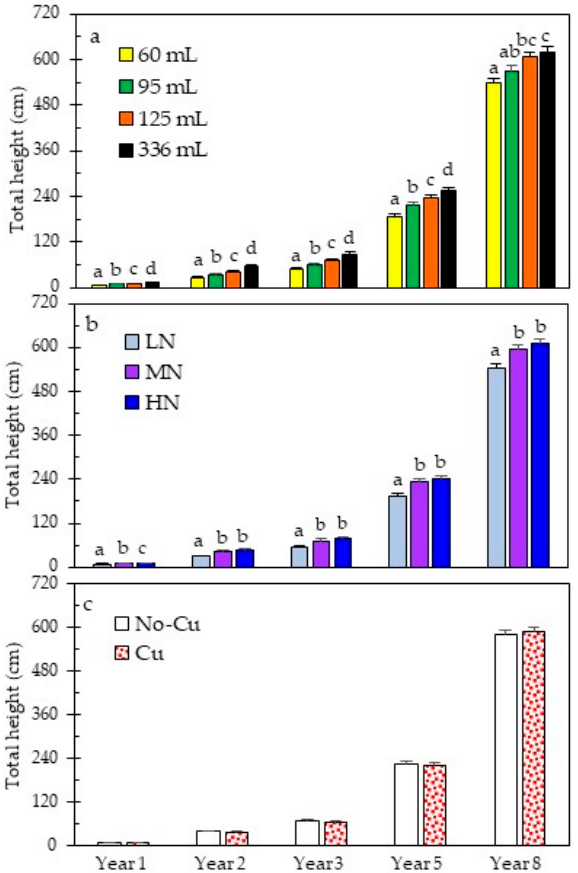
Figure 1. Longleaf pine seedling total height in response to nursery treatments from one to eight years after outplanting. ( a ) Cavity volume; ( b ) nitrogen rate: low (LN), medium (MN), and high (HN); and ( c ) copper (Cu) root pruning. Within a treatment and year, the same letter indicates no significant differences at the Bonferroni-adjusted 0.05 level. Error bars represent 1 SE.